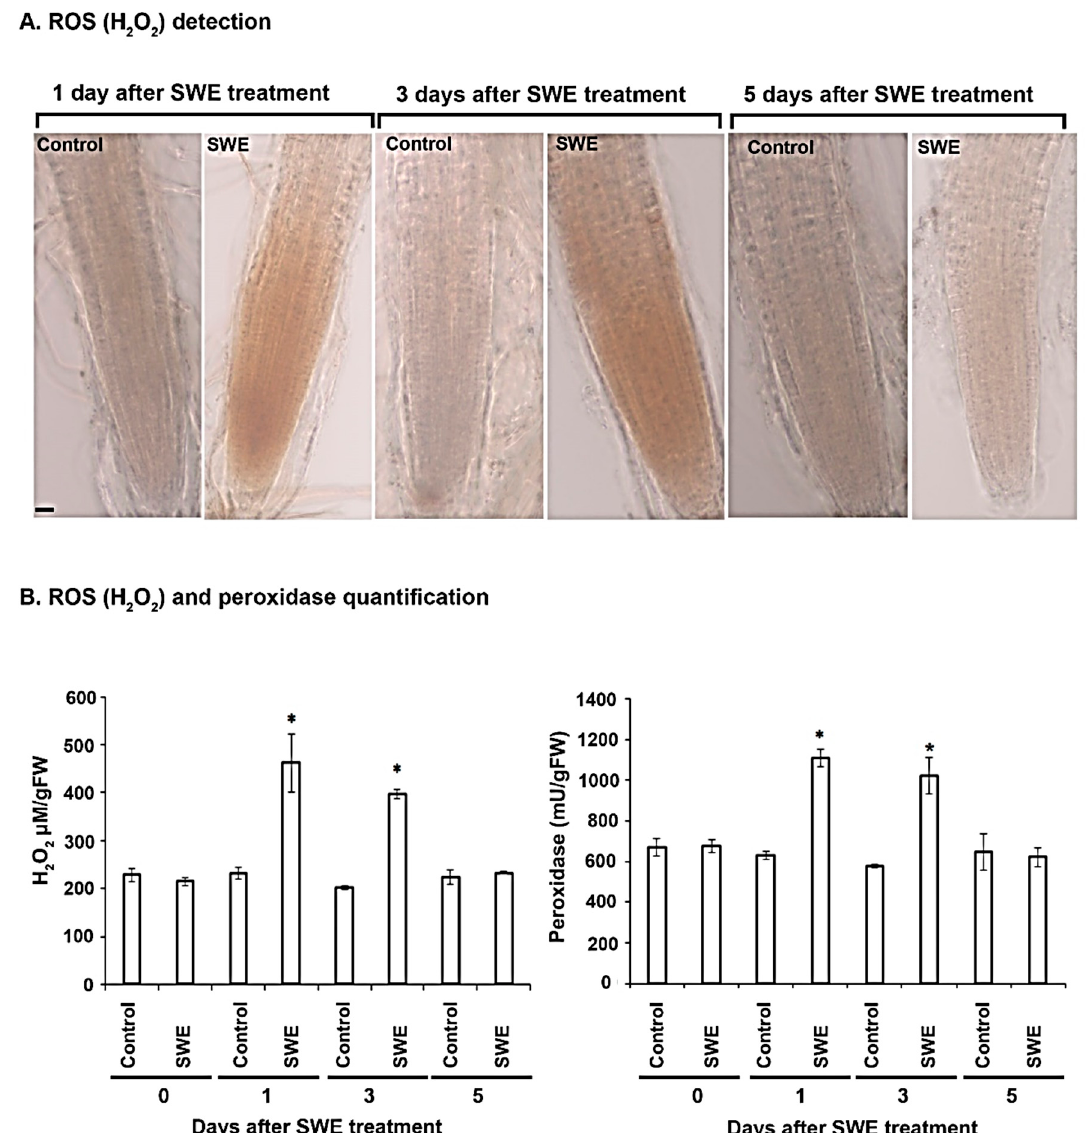
Figure 5. ROS and peroxidase quantification in A. thaliana roots following a single application of SWE or water as the control. Hydrogen peroxide (H 2 O 2 ) was detected with 3,3 ′ -diaminobenzidine (DAB) stain, resulting in a reddish-brown precipitate in the root tissue. ( A ). The production of H 2 O 2 was detected in roots that were examined after 1 and 3 days following a single application of SWE. No H 2 O 2 production was found in roots examined 5 days after SWE treatment or in all controls. Scale = 20 µm. ( B ) Quantification of H 2 O 2 and peroxidase showed that there was a significantly high concentration of each component at 1 and 3 days after the SWE application compared to the respective controls. Data shown are the mean of three independent biological replicates (each replicate consisted of 10 plants) and bars represent the standard error of the mean. * denotes a significant difference ( p < 0.05) in the treated compared to each control according to Duncan’s multiple range test.